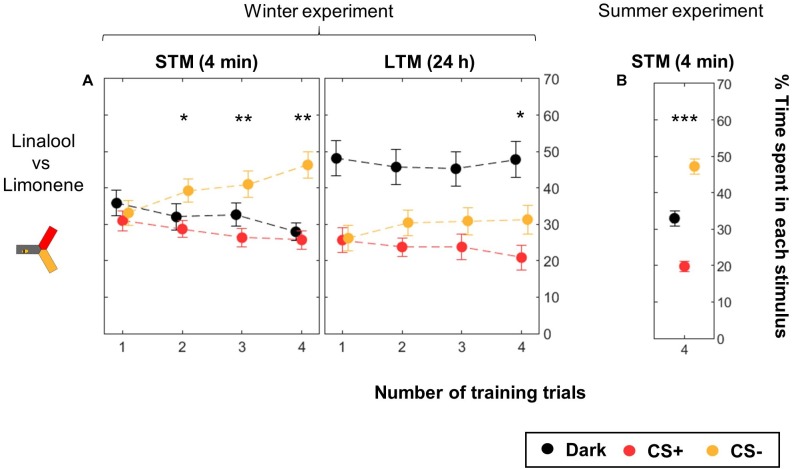
Differential conditioning of odors. During training, shocks were paired with the CS+ (red) but not with the CS- (yellow). Twenty bees were trained to one odor, and 20 bees to the other odor. The same bees were tested twice, 4 min after the end of the training and again 24 h later. Data is represented as mean ± SEM. Wilcoxon signed rank tests comparing CS+ to CS-, ∗p < 0.05, ∗∗p < 0.01, ∗∗∗p < 0.001. (A) Winter experiment, n = 160 bees (four numbers of CS presentation × 40 bees). (B) Summer experiment, n = 96 bees.